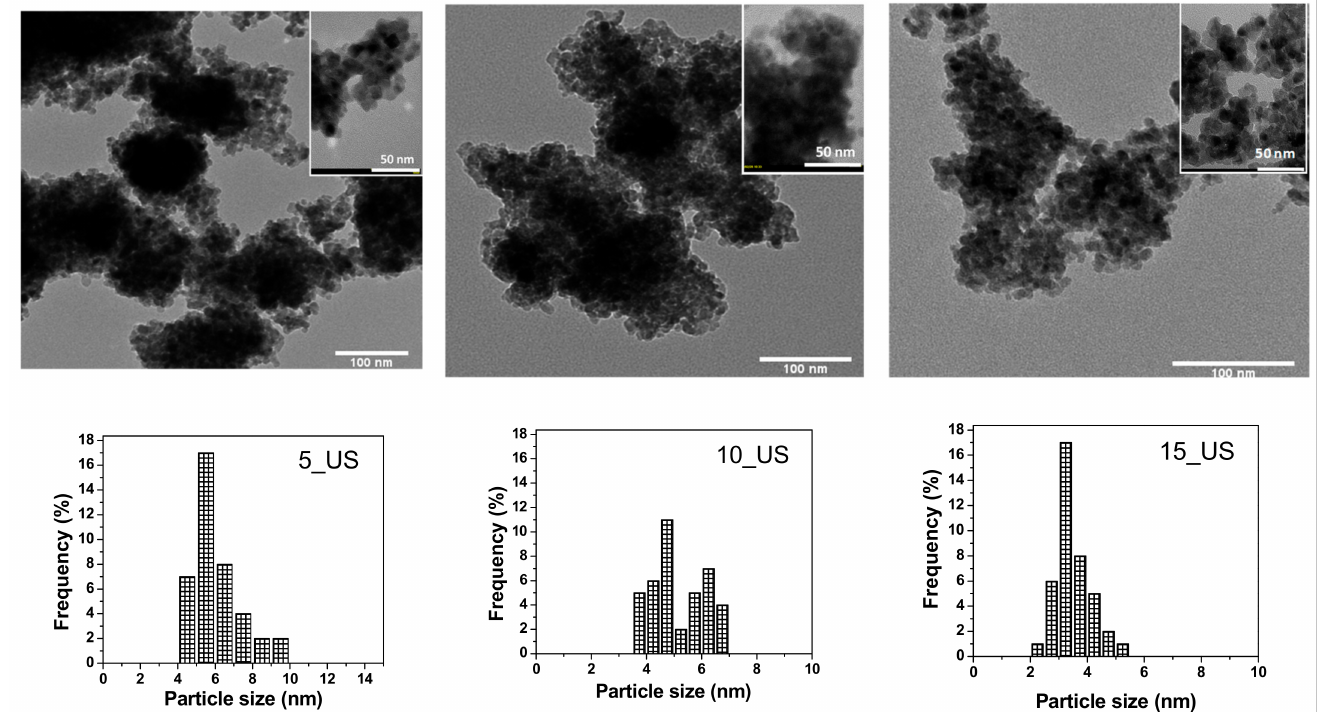
Figure 3. TEM images acquired on the US-series of titania samples, and corresponding particle size